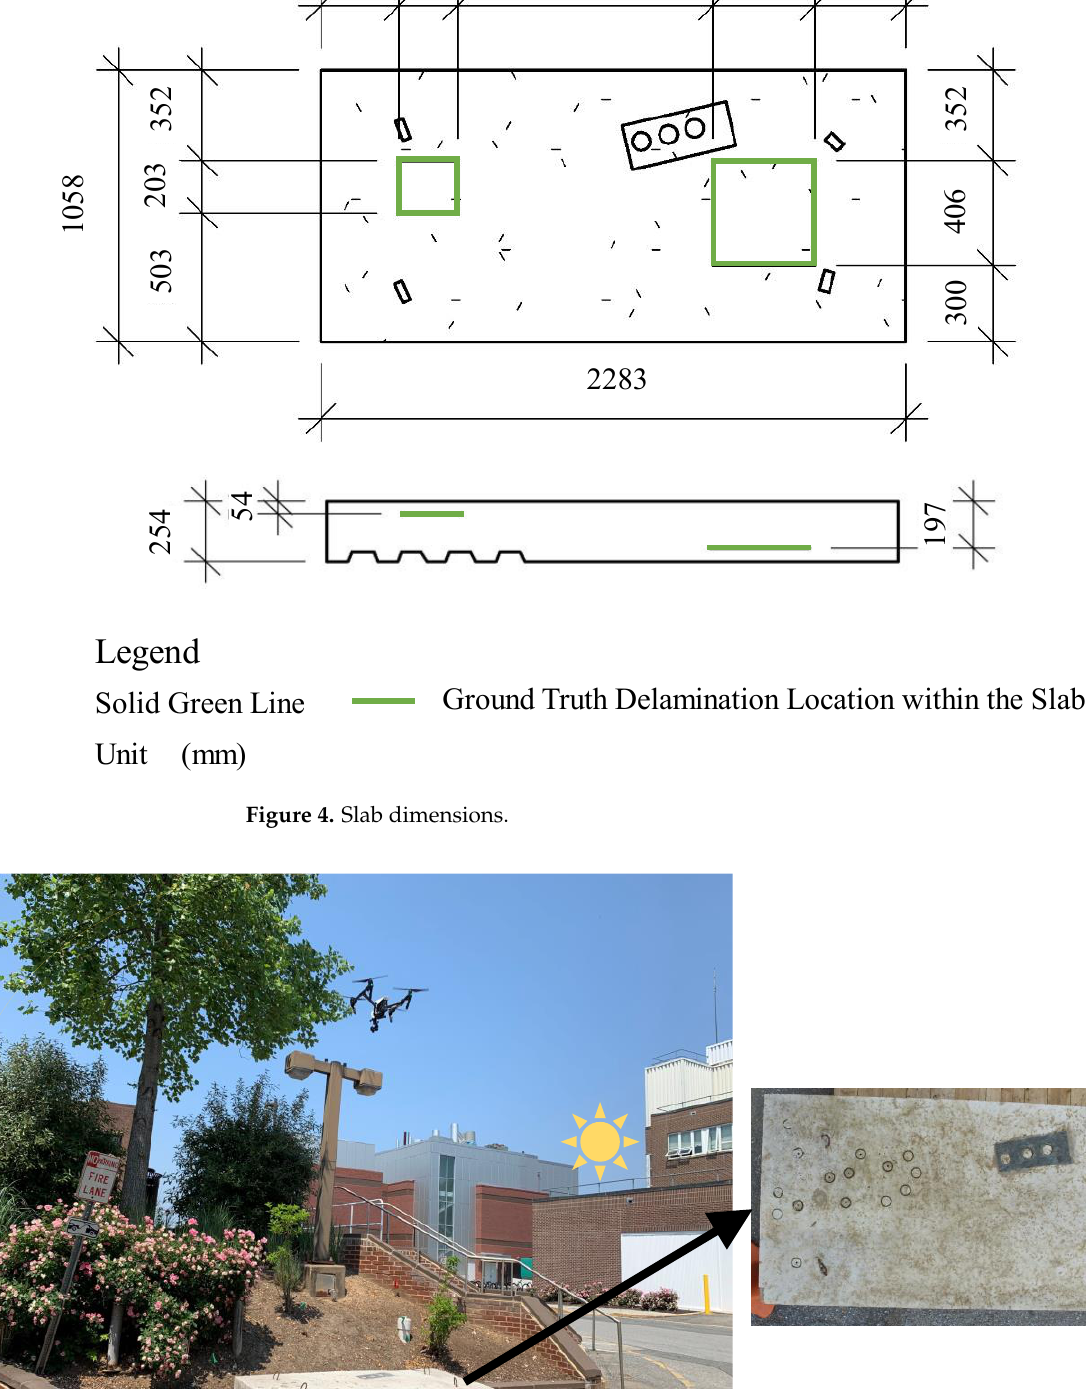
Table 3. RGB cameras specifications.